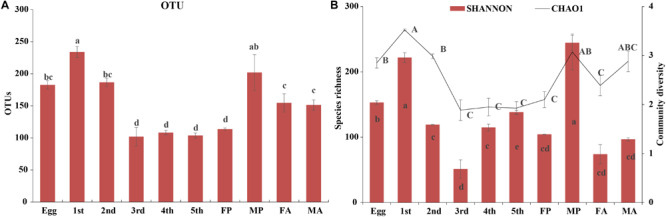
Diversity of bacterial communities across the life cycle of G. molesta. (A) The number of OTUs across the life cycle of G. molesta. (B) Species richness (Chao1 index) and community diversity (Shannon index) across the life cycle of G. molesta. Abbreviations: Gm = Grapholita molesta, 1st = first instar, 2nd = second instar, 3rd = third instar, 4th = fourth instar, 5th = fifth instar, FP = female pupa, MP = male pupa, FA = female adult, and MA = male adult. OTU values bearing different lowercase letters were significantly different (Duncan’s test, P < 0.05). Values for Chao1 and Shannon indices bearing different uppercase and lowercase letters indicated significant differences of species richness and community diversity, respectively (Welch’s test, P < 0.05).